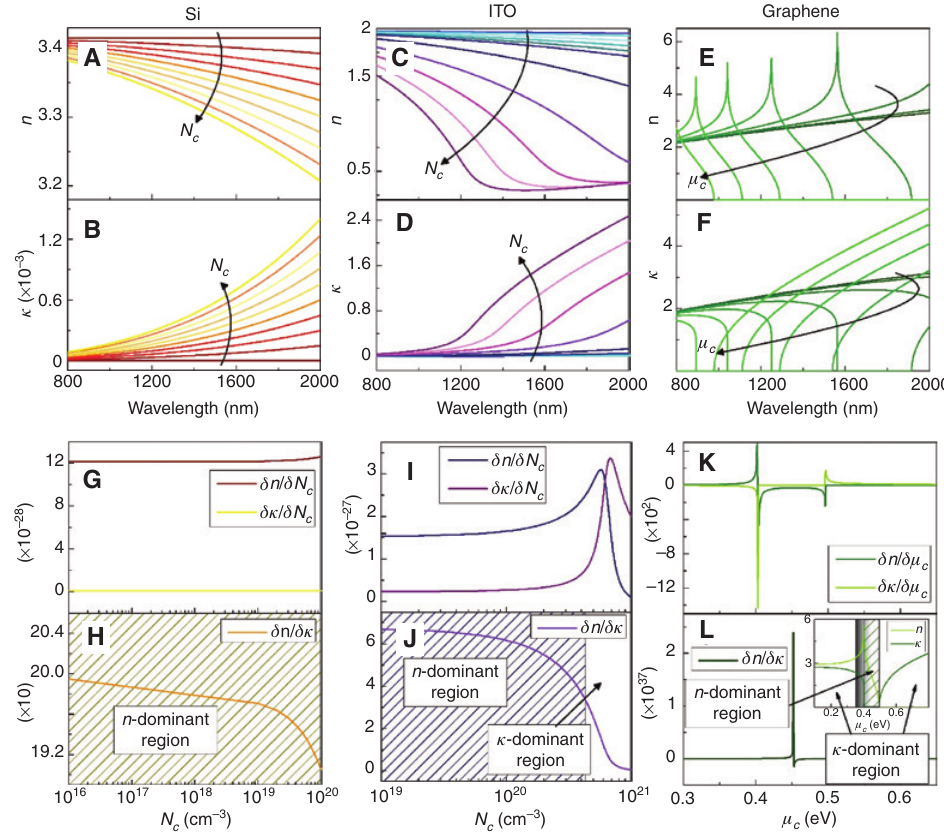
for Si and ITO, c